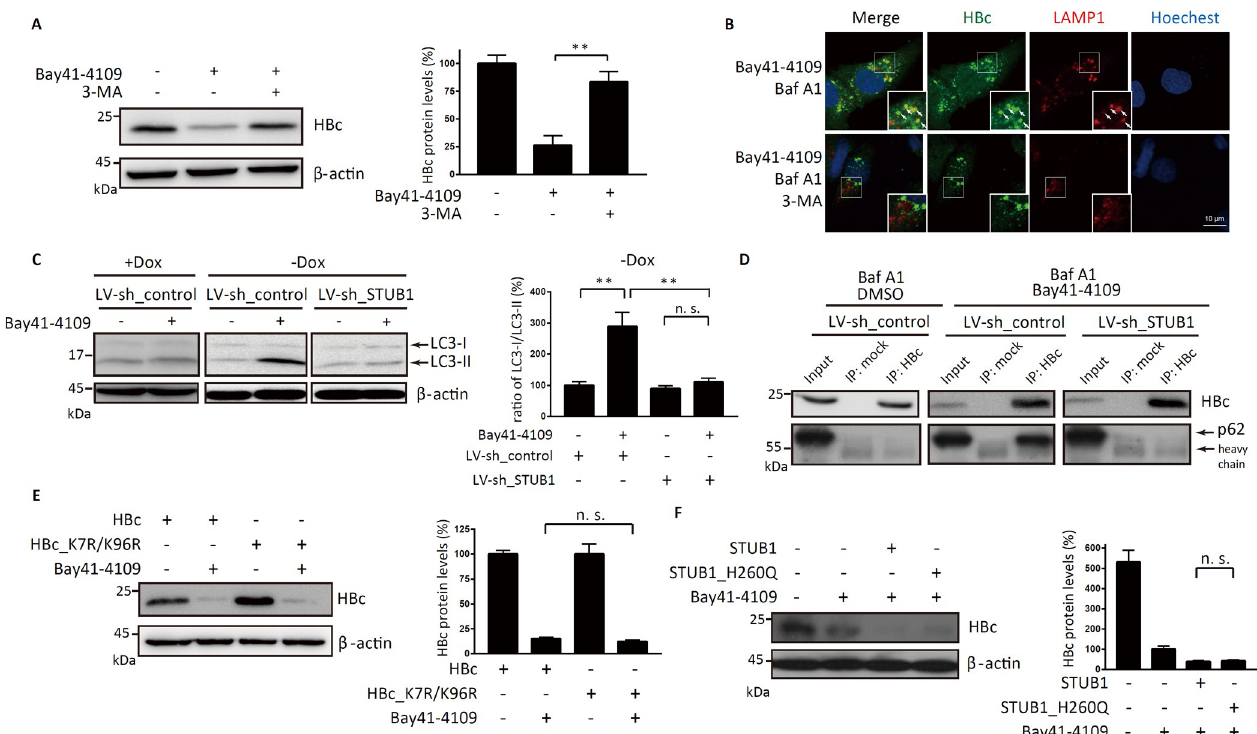
Fig 4. Aberrant non-capsid polymers induced by Bay41-4109 are degraded via STUB1-mediated macroautophagy. (A) HepAD38 cells were treated with 1 μ M Bay41 or DMSO for 1 d, followed by treatment with 10 mM 3-MA or DMSO as indicated for 24 h. Proteins were detected by western blot using antibodies recognizing the indicated proteins (left panel). (B) HepAD38 cells were treated with 1 μ M Bay41-4109 or DMSO for 24 h followed by treatment with 0.1 mM BafA1 and 10 mM 3-MA (or BafA1 alone) for 12 h. The cells were immunostained for HBc (green) and LAMP1 (red) as indicated. Nuclei were stained with Hochest33342. Areas indicated by white boxes are enlarged. Arrows point to typical co-localized sites. Scale bar is 10 μ m. (C) HepAD38 cells were transduced with LV-sh_STUB1 or LV-sh_control, cultured in the the presence or absence of Dox, and treated with 1 μ M Bay41-4109 or DMSO for 24 h. (D) HepAD38 cells were transduced with LV-sh_STUB1 or LV-sh_control, treated with 1 μ M Bay41-4109 or DMSO for 1 d, and then treated with 0.1 mM BafA1 for 12 h. Cell lysates were immunoprecipitated with HBc antibodies or mock antibodies. Proteins were detected by western blot using antibodies recognizing the indicated proteins. (E) Huh7 cells expressing HBc or lysine-free HBc mutant (HBc_K7R/K96R) were treated with 1 μ M Bay41-4109 or DMSO. The proteins were detected by western blot using the indicated antibodies. (F) HepAD38 cells were transfected with STUB1, STUB1_H260Q, or empty vector. At 24 h after transfection, the cells were incubated with or without 1 μ M Bay41-4109 for 2 d. The proteins were detected by western blot using the indicated antibodies. (A, B, C, E, F) The right panels show the quantification results of three independent immunoblots as relative percentages (HBc/actin) (A, E, F) or (LC3-I/LC3-II) (C) with the control sample set to 100%. The error bars indicate ± SD. �� p < 0.01, p value was calculated by unpaired two-tailed student’s